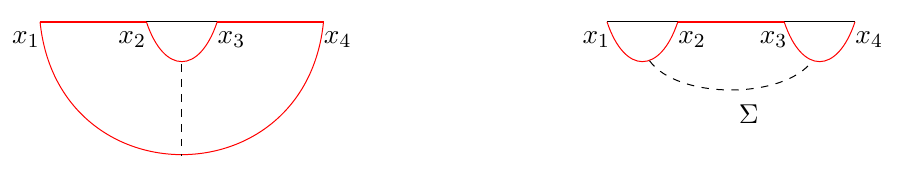
Figure 6 . Definitions for the analytic formulas for the EWCS in AdS 3 . Left : before Möbius transformation. Right : after Möbius transformation and